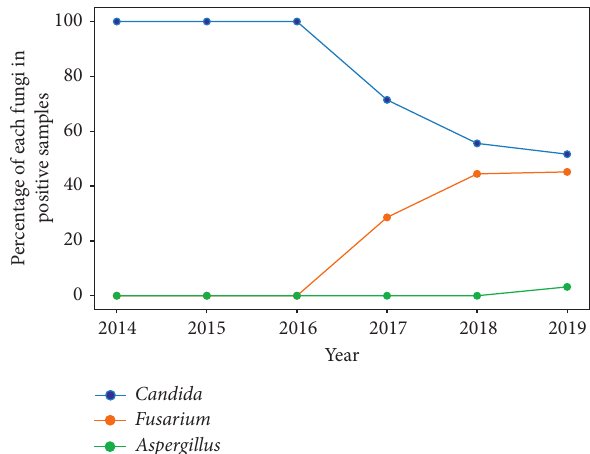
Figure 12: Percentage of each fungi in positive samples.